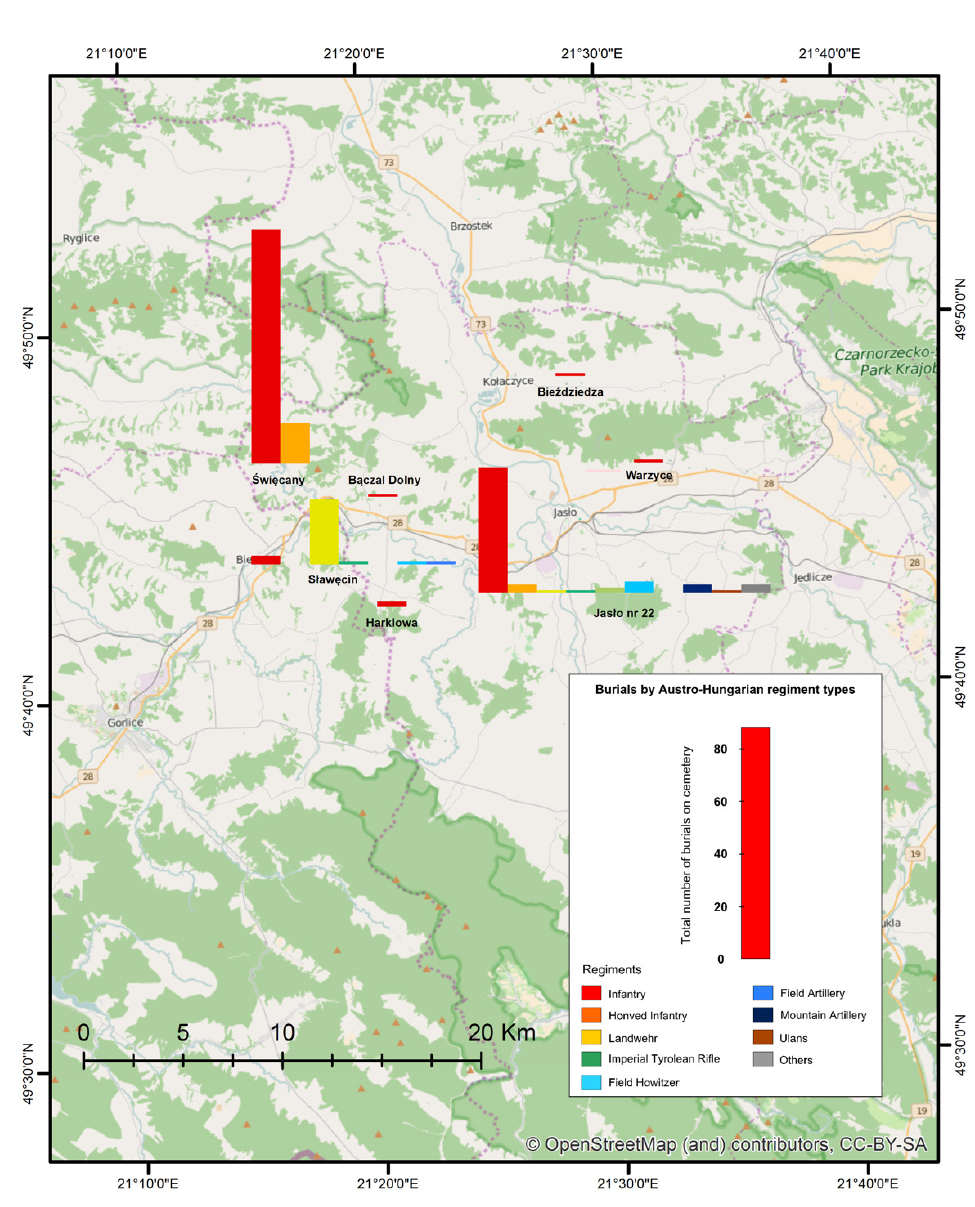
Fig. 6. Buried soldiers of the Austro-Hungarian army by regiment